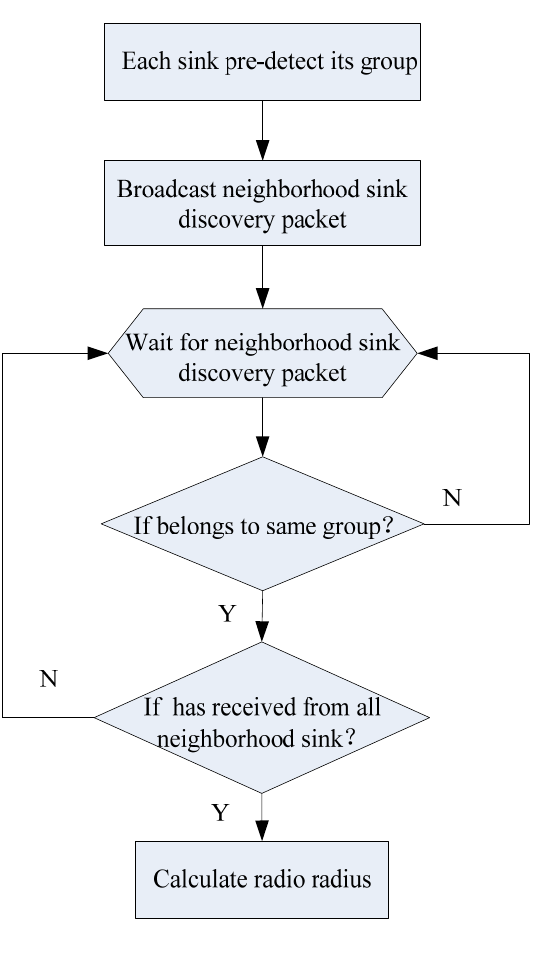
Figure 9. Flow chart for MSCWSNS-PC in each